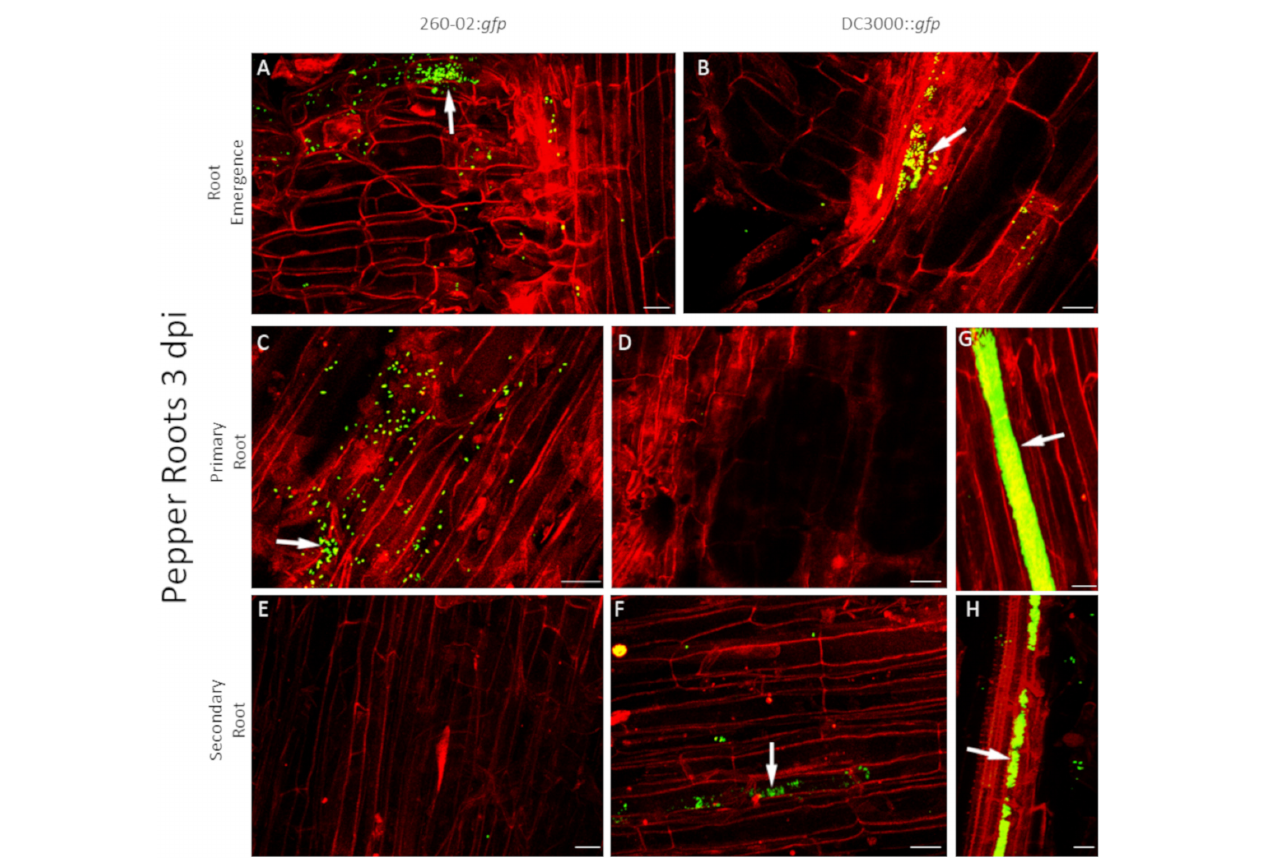
FIGURE 6 | Confocal microscopy on pepper roots, 3 days after inoculation with bacterial strains. The panel shows representative pictures from the microscopy observations. In green is the fluorescence obtained by exciting with a wavelength of 488 nm, which produces fluorescence from the GFP used to tag the bacterial strains, in red that obtained by exciting with a wavelength of 594 nm, which produces autofluorescence from phenolic compounds and allows to visualize plant material, in particular cell walls. Yellow color is given by overlap of red and green fluorescence. White arrows indicate examples of GFP fluorescence on the root surface. Panels (A,C,E) are taken from plants inoculated with strain 260-02: gfp ; panels (B,D,F–H) are taken from plants inoculated with strain DC3000:: gfp . Panels (A,B) portray zones of emergence of secondary roots; panels (C,D,G) portray primary roots; panels (E,F,H) portray secondary roots. In each picture, the scale bar reported in the lower right corner corresponds to 20 µ